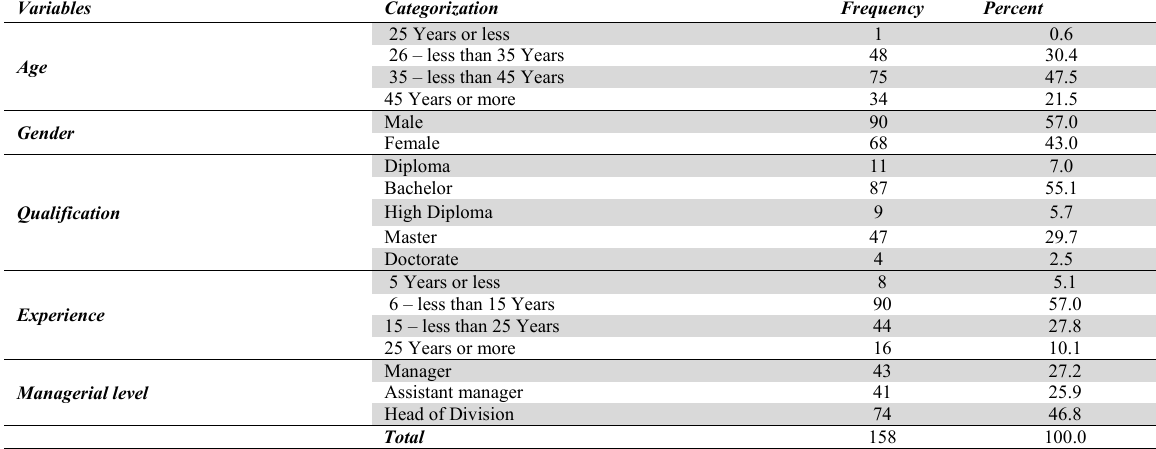
Descriptive analysis for the personal & occupational characteristics of the study sample